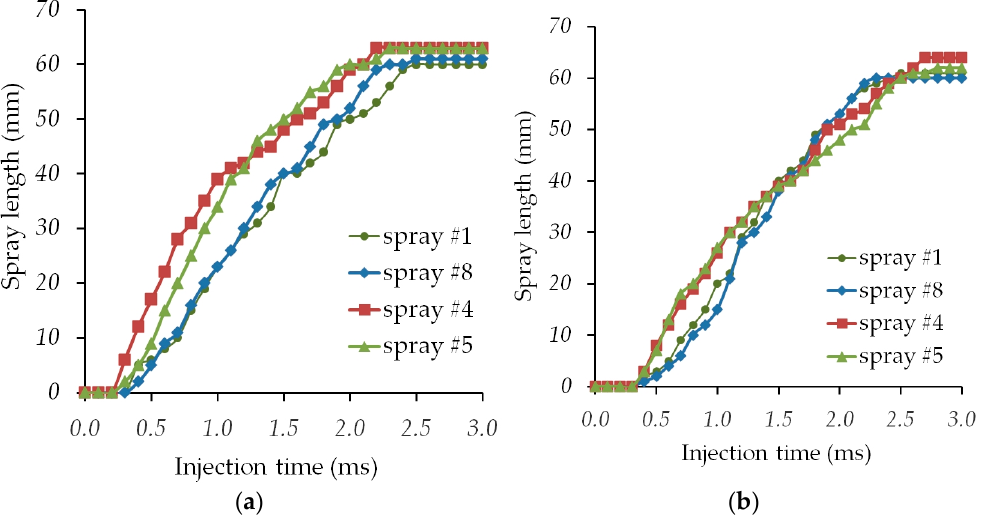
Figure 9. Dynamics of change in the length of the fuel sprays 1, 8 and 4, 5 for the nozzle 1 ( a ) and the nozzle 2 ( b ) with a rail pressure of 100 MPa.